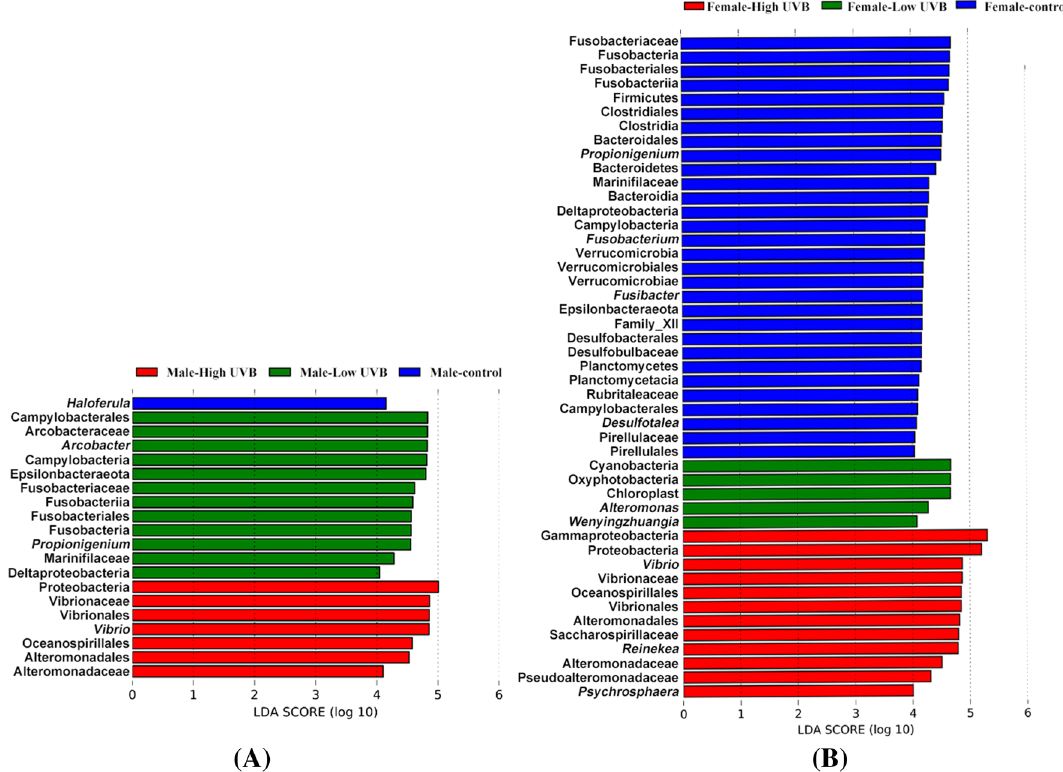
Figure 7. Bacterial species with significant differences in abundance on male ( A ) and female ( B ) S. thunbergii under increased UV-B radiation (Forest plot showing taxa whose abundance was significantly different between the control group (blue), low-UV-B radiation group (green) and high UV-B-radiation group (red), as determined using the KW test. LDA score (effect size) indicating significant differences in bacterial taxon abundance ( P value: Wilcoxon rank-sum test, LDA score >